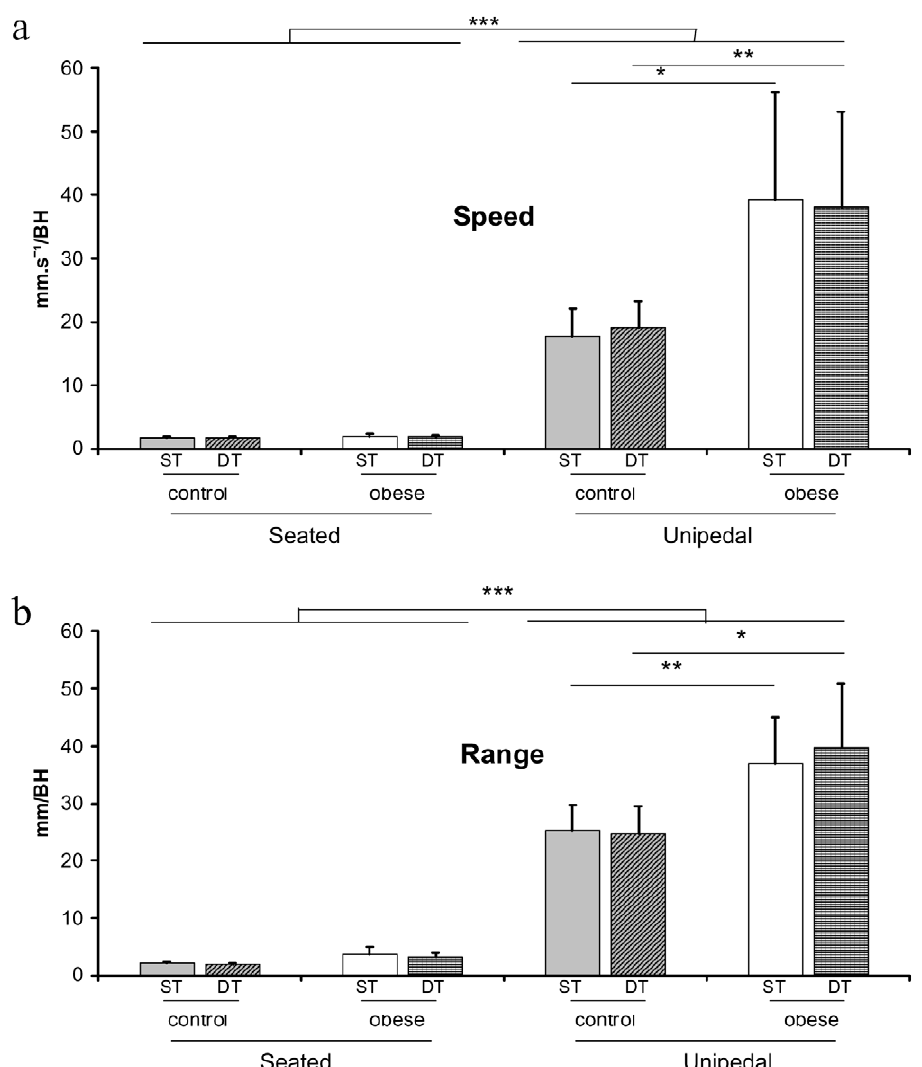
Figure 2. Mean CoP speed (a) and range (b) and standard deviation for the two groups and the two postural conditions in the simple postural task (ST) and dual-task (DT).